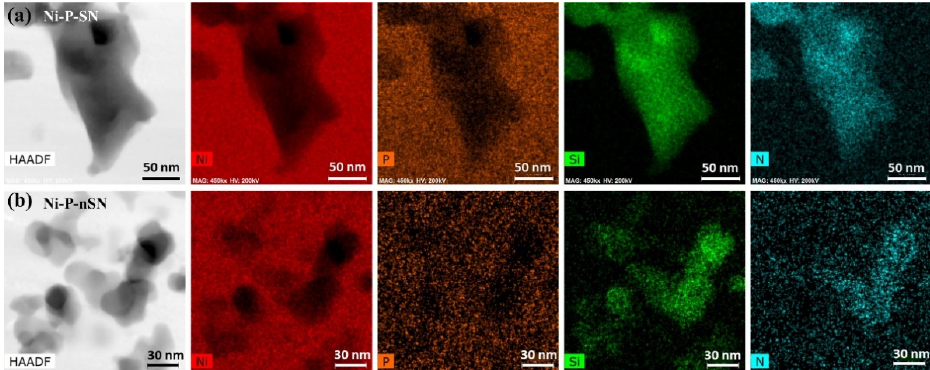
Figure 6. ( a ) HAADF image of Ni-P-SN specimen depicts the incorporated SN particles. Similarly, ( b ) HAADF image of Ni-P-nSN specimen depicts the incorporated nSN particles. The elemental mapping images of Ni, P, Si, and N of the composites Ni-P-SN and Ni-P-nSN are shown in the corresponding rows.